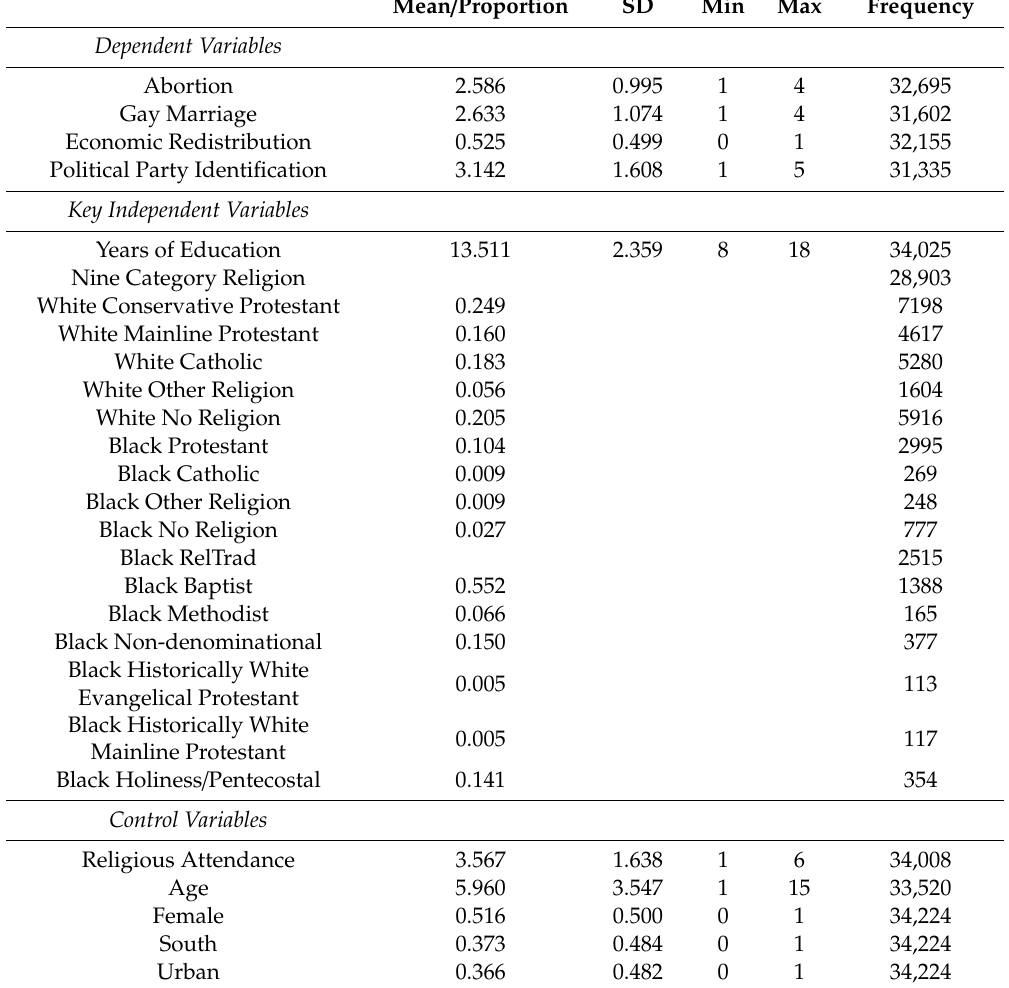
Table 1. Descriptive statistics (Pew 2014 Religious Landscape